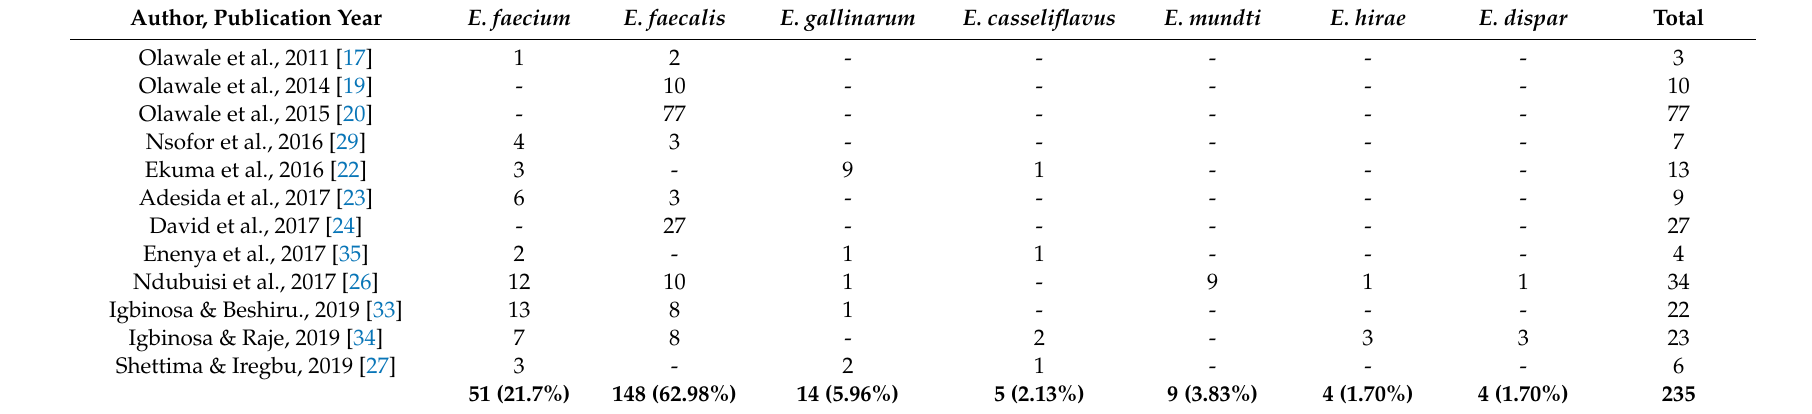
Table 2. Species distribution of VRE across